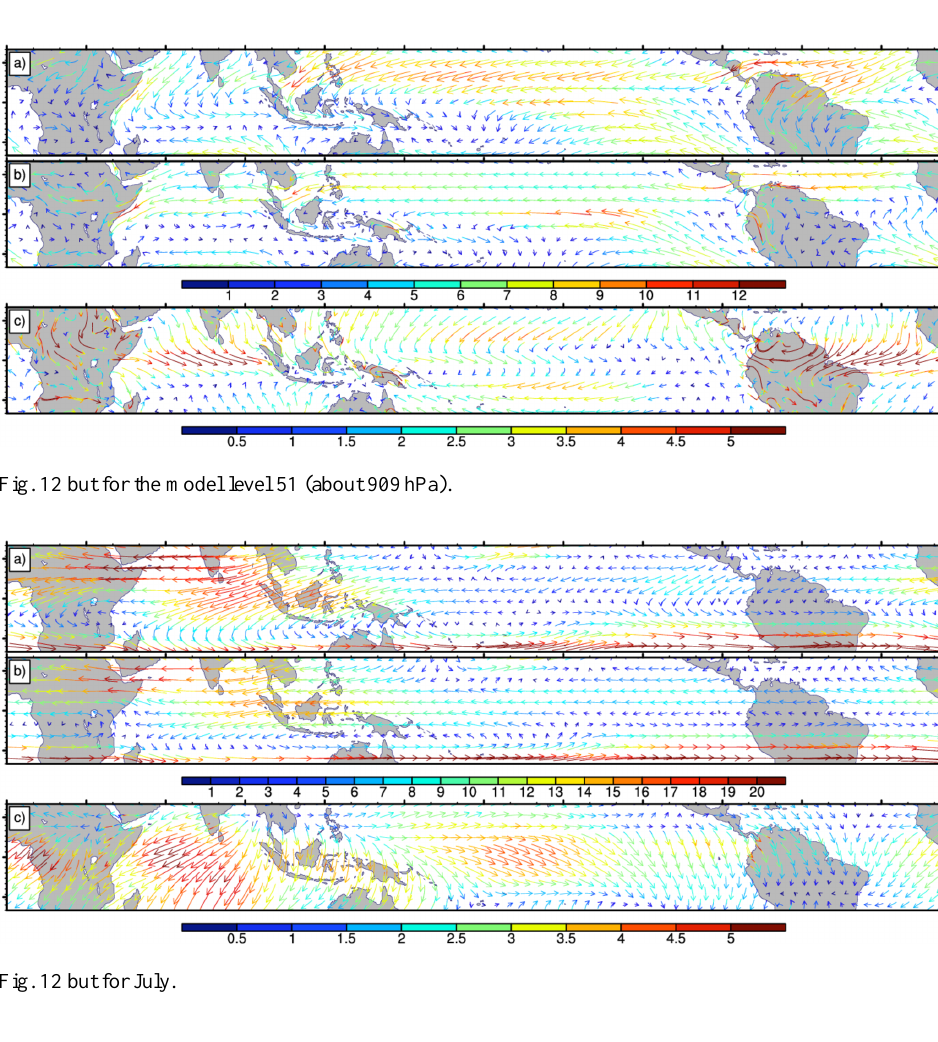
Figure 14. As in Fig. 12 but for